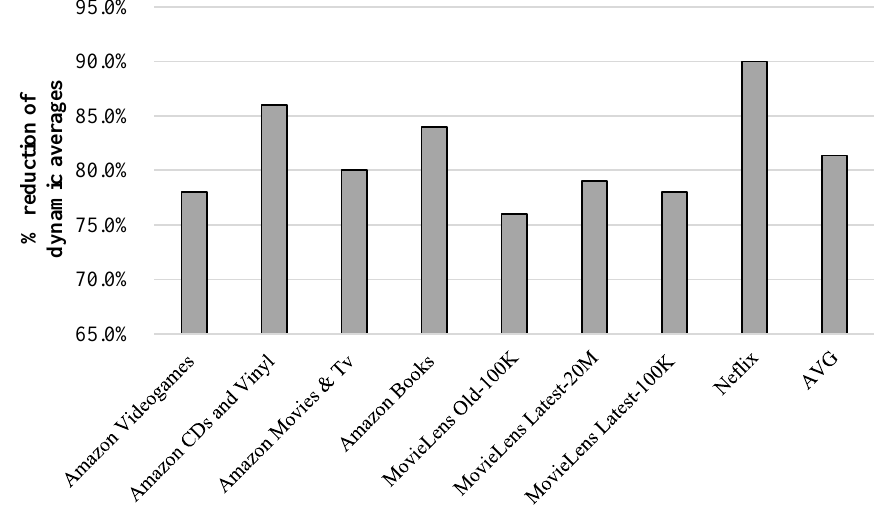
Figure 5. Storage needs reductions achieved by the DA